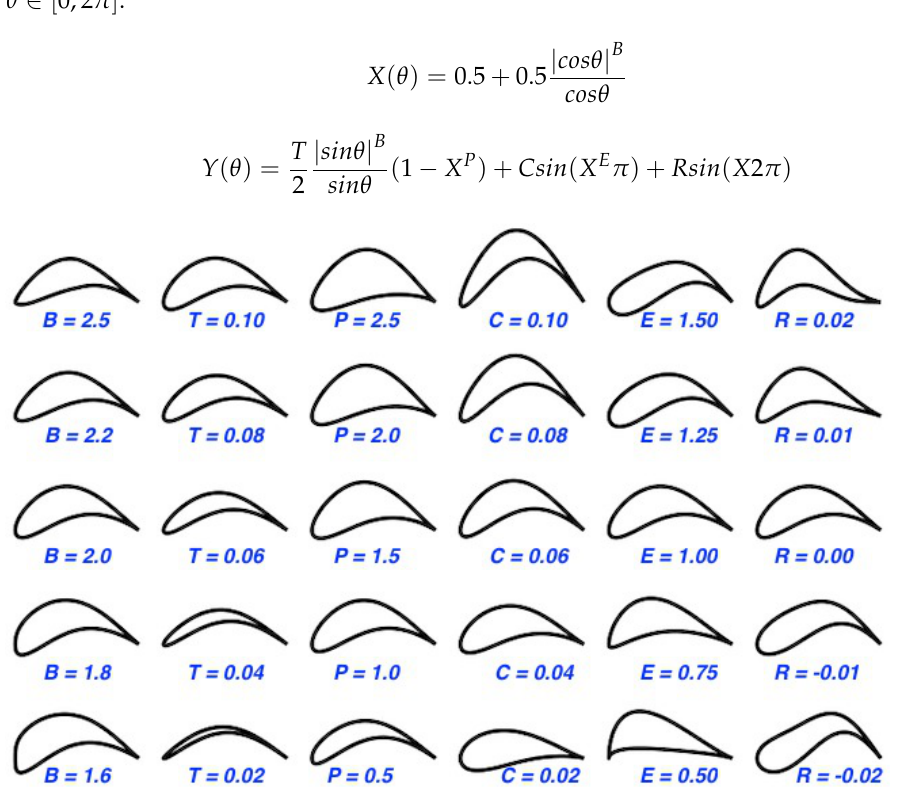
Figure 1. Airfoil parameterization method [12] and the impact of each